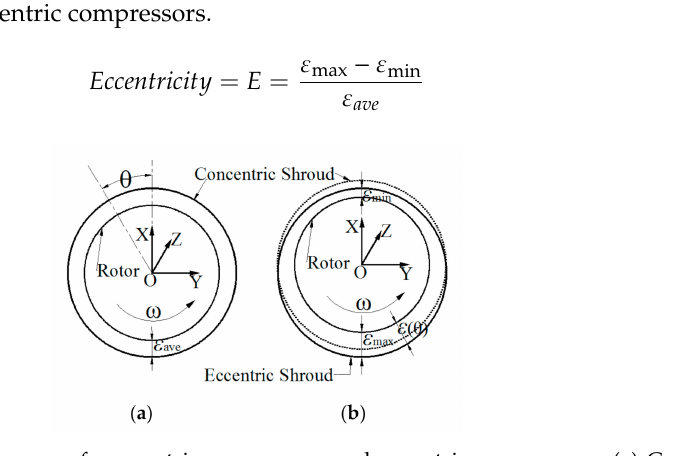
Figure 3. Schematic diagram of concentric compressor and eccentric compressor. ( a ) Concentric compressor; ( b ) eccentric compressor.